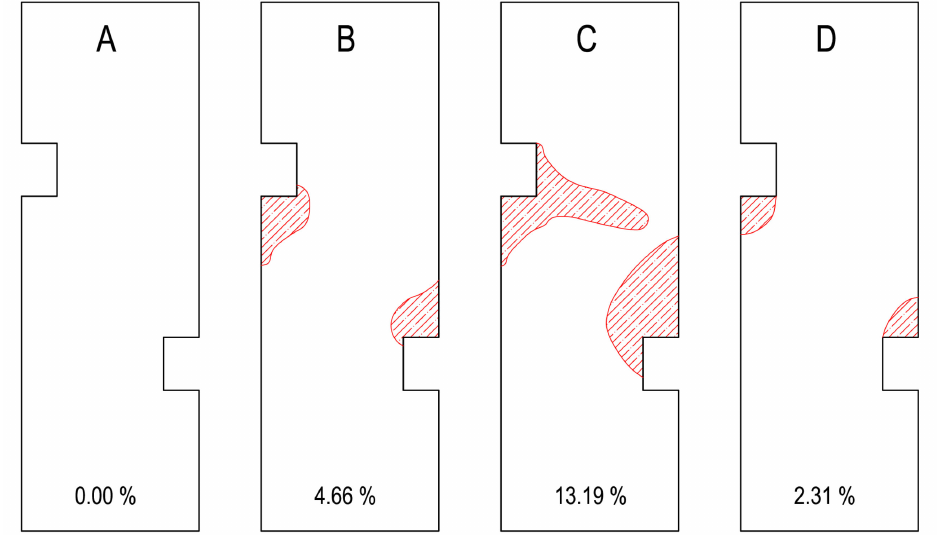
Figure 9. Areas and their percentages where acoustic tracing revealed a loss of bond strength after the eight loading cycles for system A, system B, system C and system